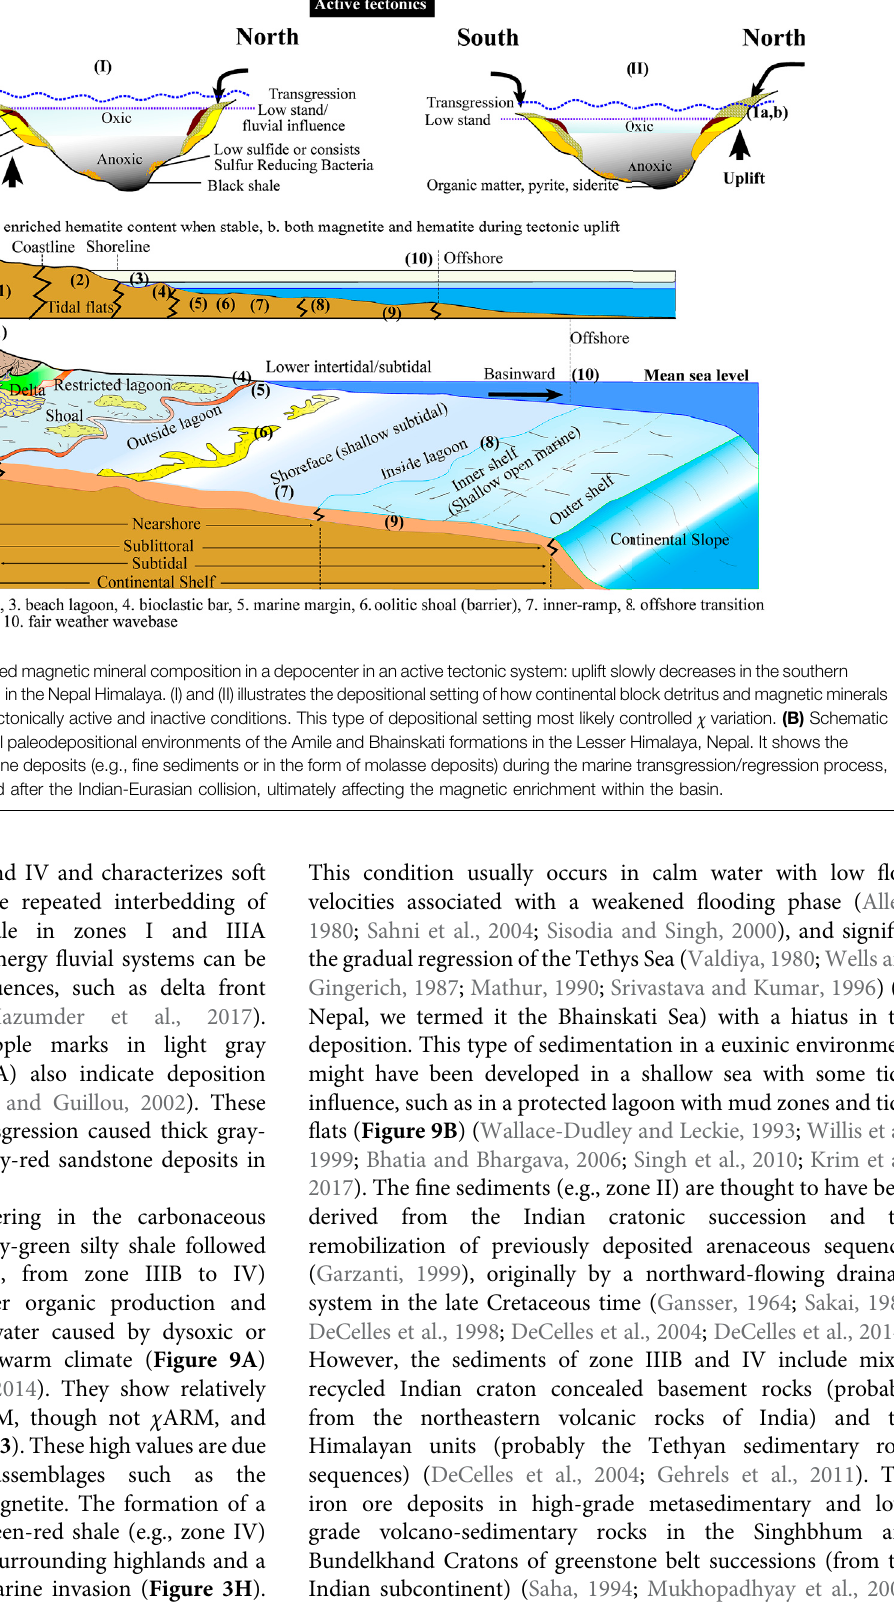
Frontiers in Earth Science |